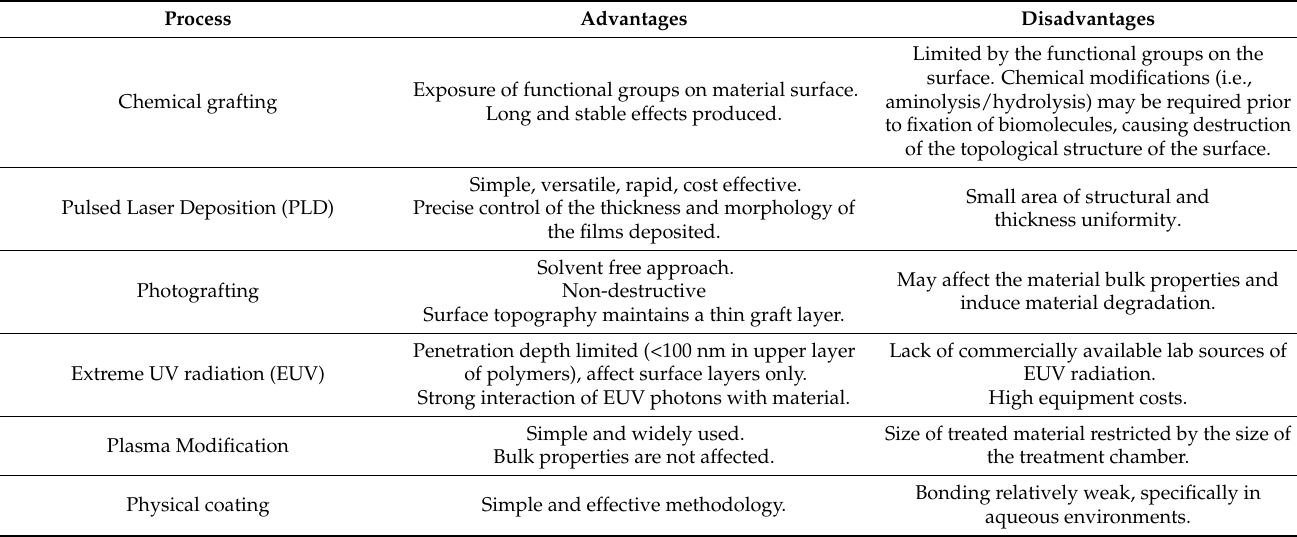
Table 2. Summary of surface enhancement treatments on polymers [89,102,105,109,110].